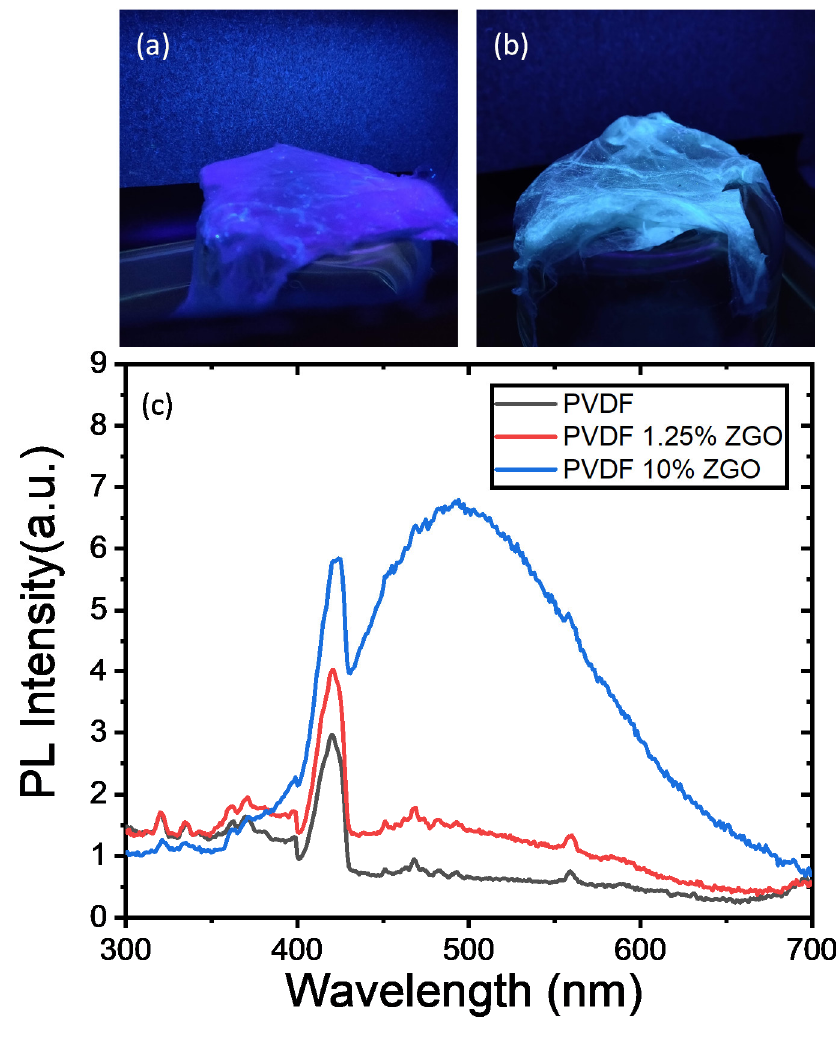
Figure 4. Digital image of ( a ) PVDF and ( b ) PVDF-ZGO fibers under UV lamp irradiation. ( c ) Photoluminescence excitation spectra of PVDF fiber mats with 1.25 wt % and 10 wt % ZGO loading.